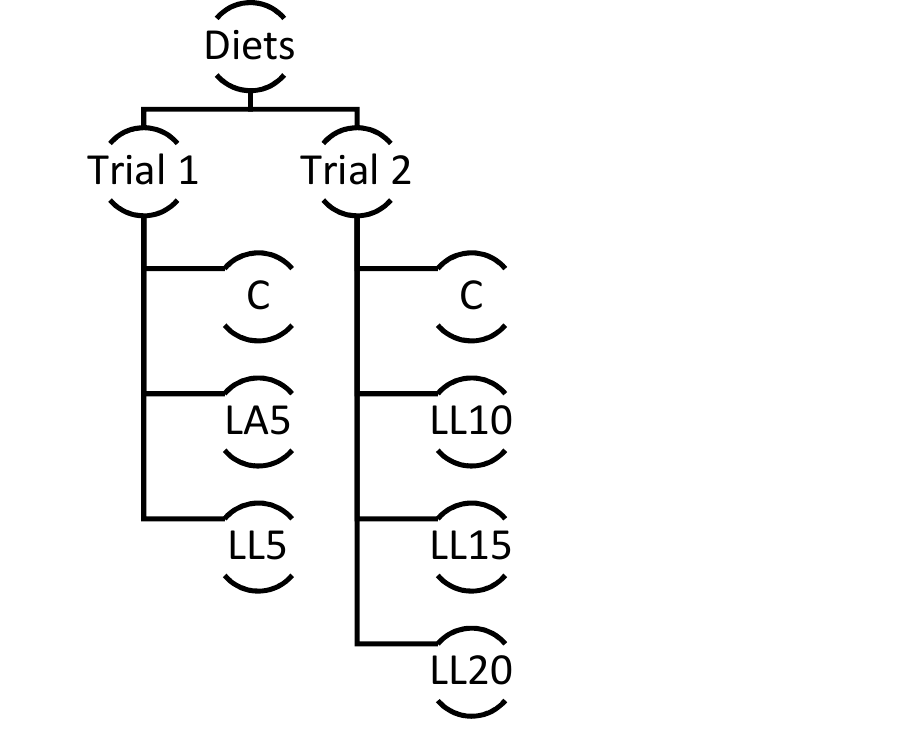
Table 1. Chemical composition (g/kg DM) and levels of inclusion of diet components (g/kg as fed) of the different treatment diets.